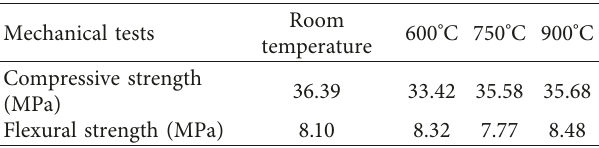
Table 2: Strength of mortar specimens containing ceramsite treated at different temperatures.